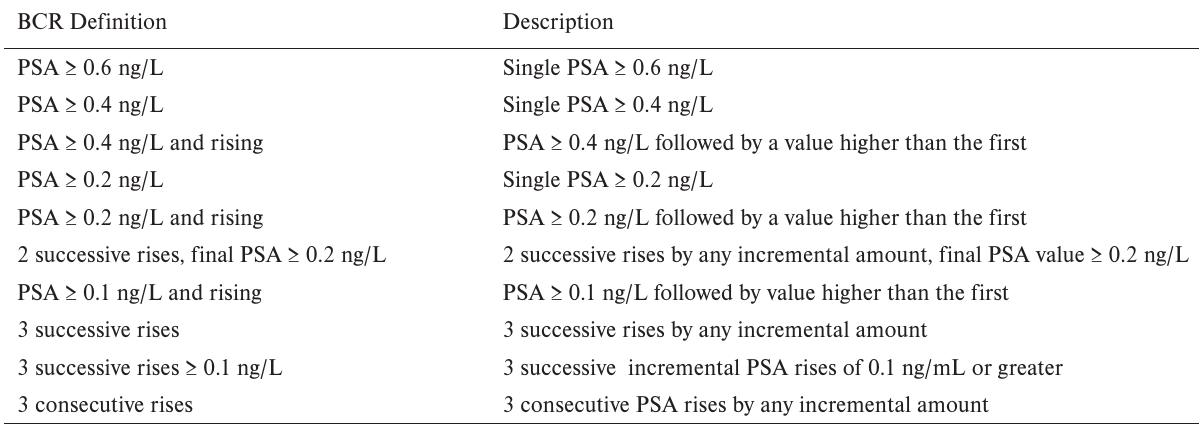
Table 1. Various definitions of biochemical recurrence after radical prostatectomy used in clinical practice.